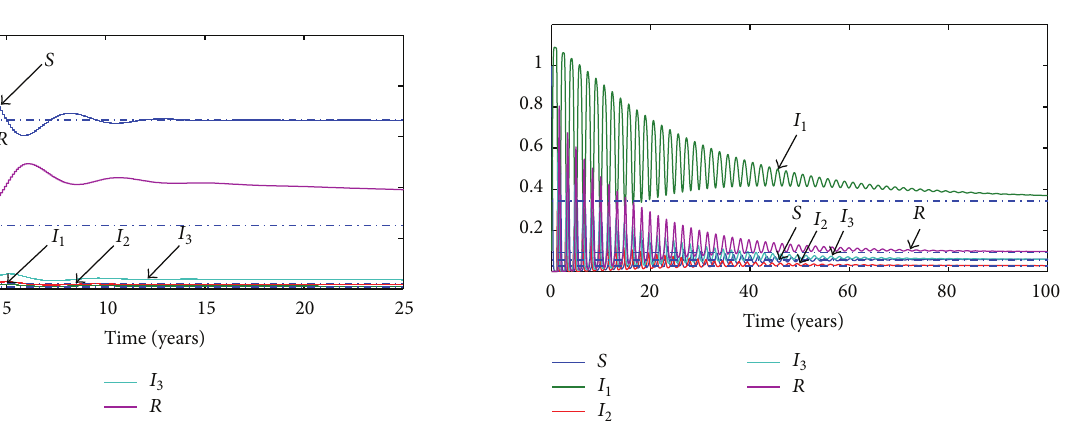
Figure 3: Dynamic of the subpopulations for 𝑅 0 = 1.5 . The dotted lines represent the predicted endemic values.